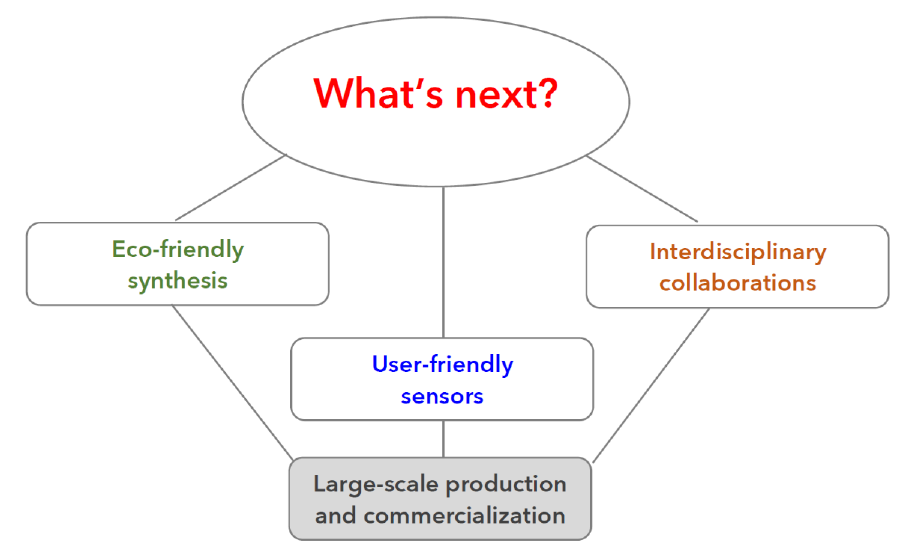
Figure 24. Outlook figure about the new perspectives in polymer-based sensors .